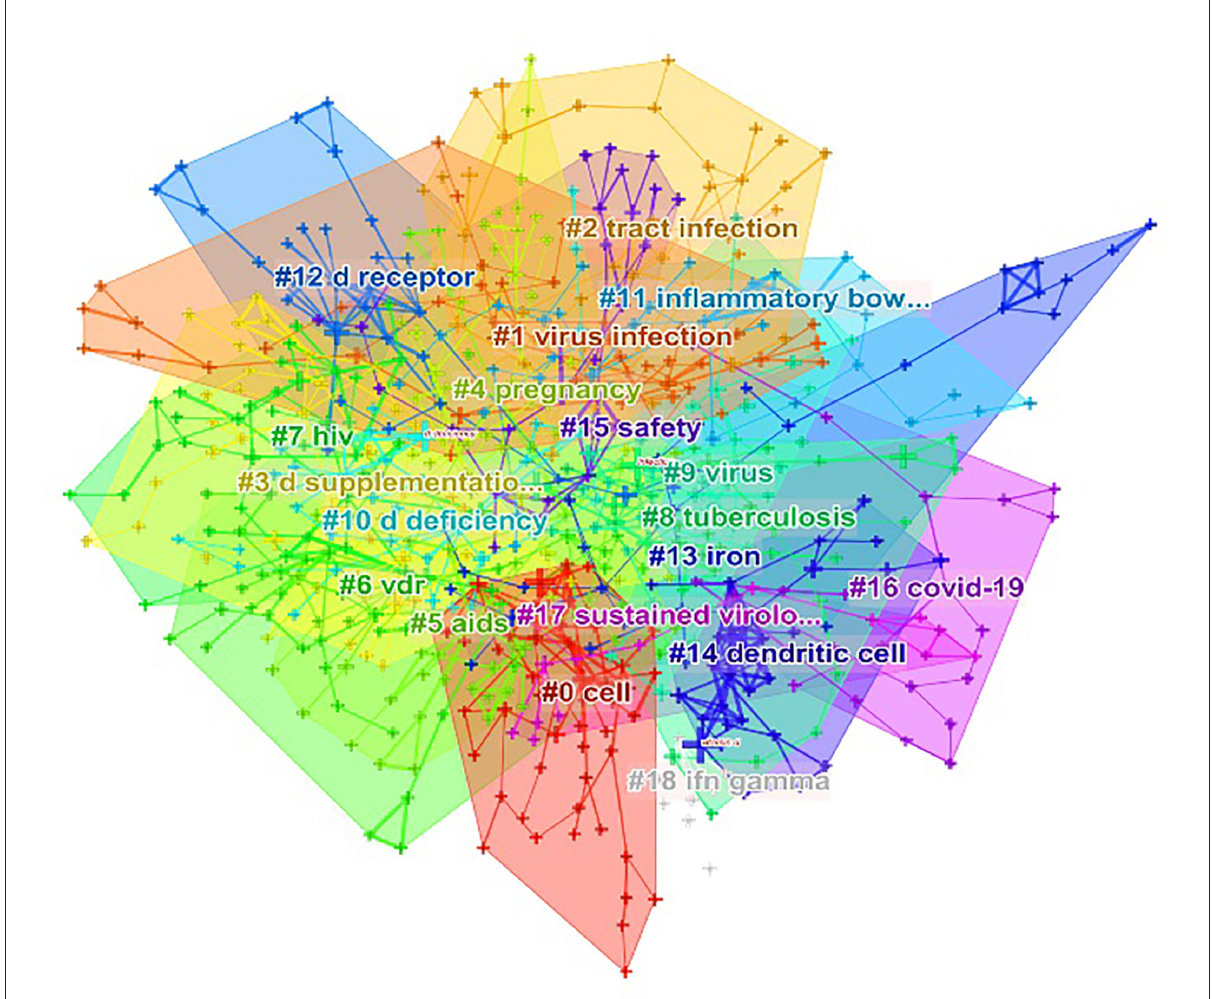
and the antimicrobial peptide cathelicidin (37) that triggers autophagy